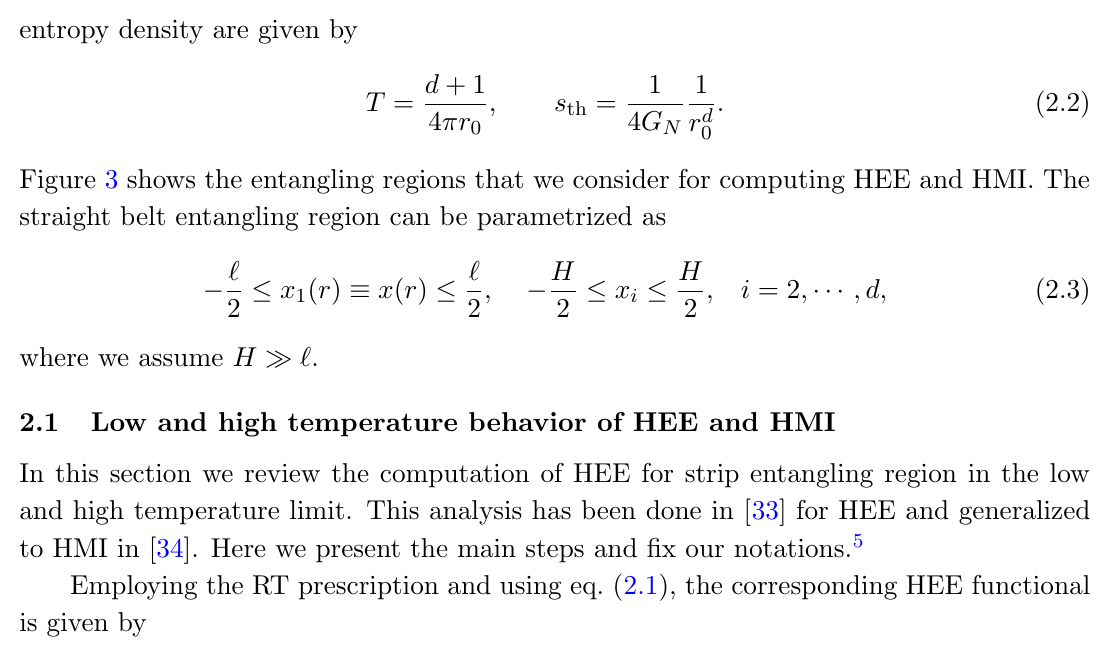
Figure 3 . Schematic con(cid:12)guration for computing HEE (left) and HMI (right). In the latter case, we just demonstrate the connected con(cid:12)guration where the HMI is